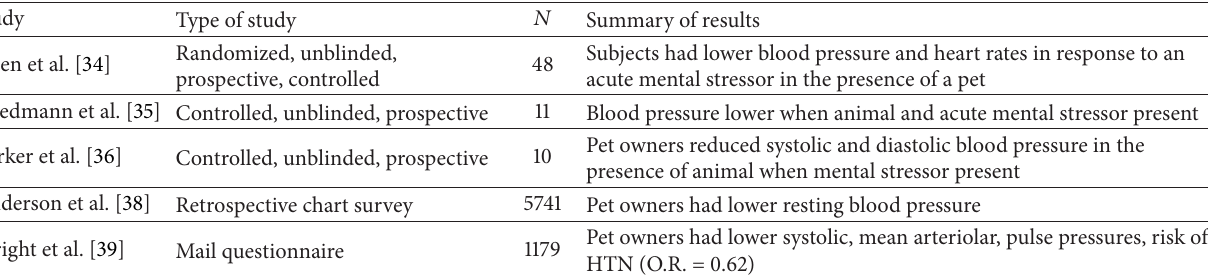
Table 2: Studies on the use of animals on blood